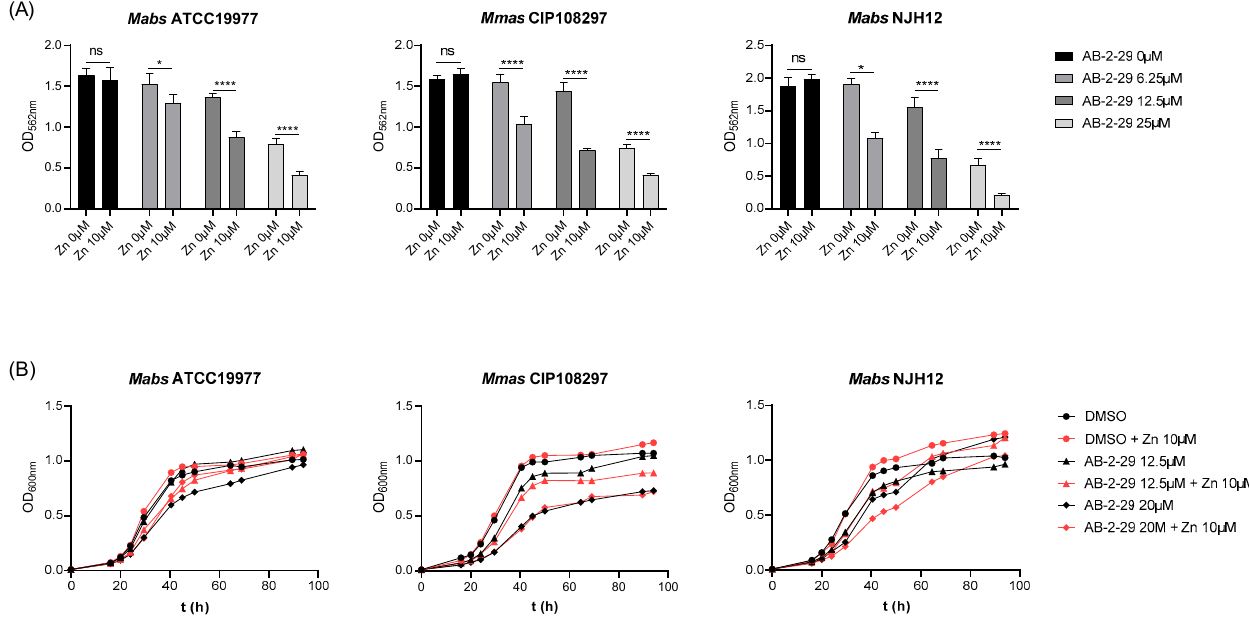
Figure 4. Potentiation of the antibiofilm activity of AB-2-29 by zinc . ( A ) Biofilm formation by Mabs ATCC 19977, Mabs NJH12 and Mmas CIP108297 in SCFM after 5 days of incubation in the presence or absence of AB-2-29 (0, 6.25, 12.5 or 20 μ M) and zinc (0 or 10 μ M). The results presented are the means (±SD) of sextuplicate wells and are representative of at least two independent experiments. Asterisks denote statistically significant differences between biofilm inhibitor treatment with and without zinc (* p < 0.05 and **** p < 0.00005); ns: not significant. ( B ) Growth of Mabs ATCC 19977, Mabs NJH12 and Mmas CIP108297 in SCFM in the presence or absence of AB-2-29 (0, 6.25, 12.5 or 20 μ M) and zinc (0 or 10 μ M). The results presented are representative of at least two independent experiments.